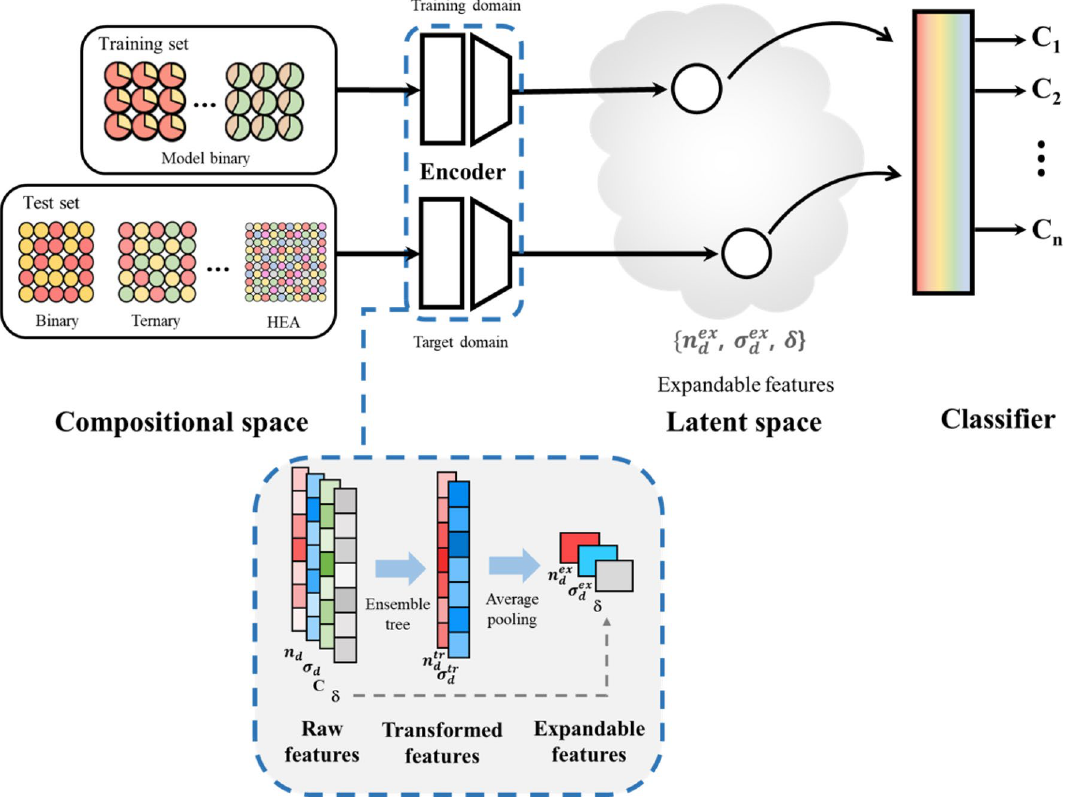
ex ex n d ( N ) , d , σ d } features from { ex ex d , σ d } features, ex ex d , σ d } is used for the training of the calculated binary alloy ex ex d , σ d } features ex ex d , σ d } features obtained